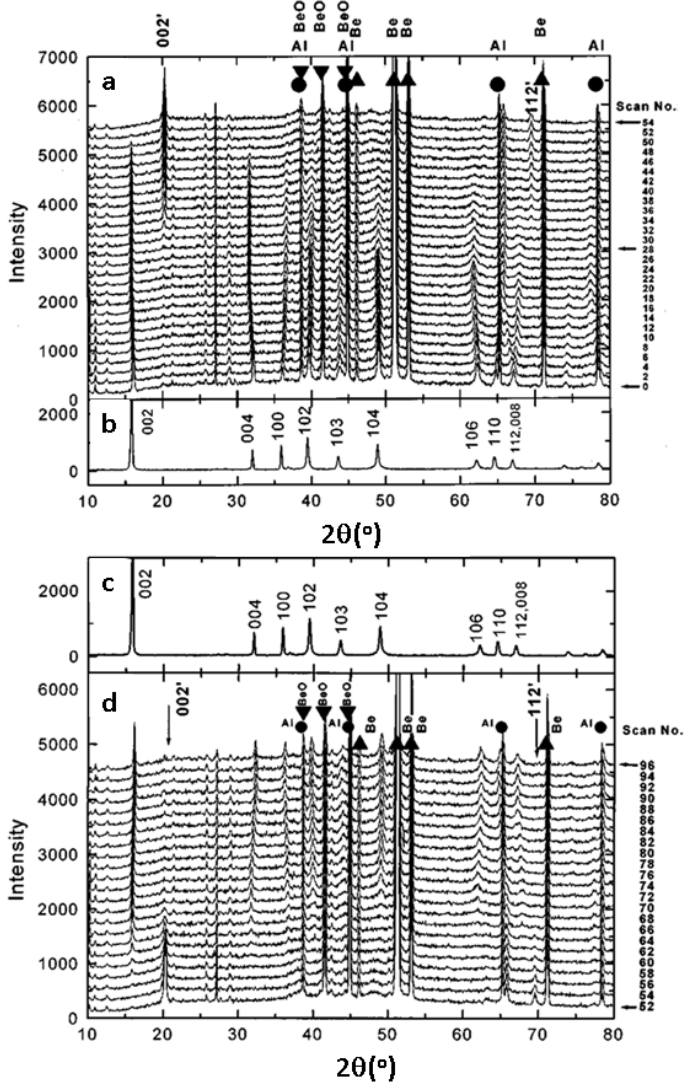
Figure 8. XRD pattern of P2-Na 2/3 Ni 1/3 Mn 2/3 O 2 cell: ( a ) during first charge; ( b ) before cycling; ( c ) after first discharge; ( d ) during first discharge; Al, Be, BeO are contributions from cell components [167]; with permission from